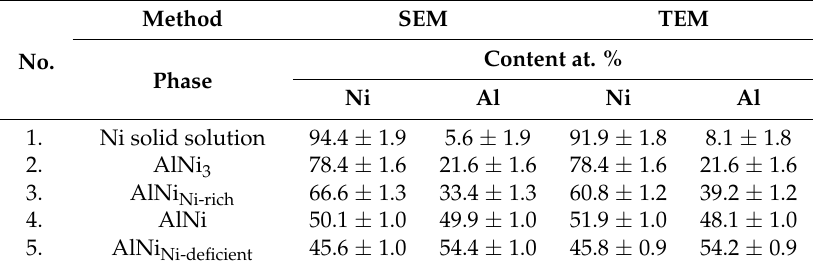
Table 4. Comparison of the chemical compositions obtained by SEM and